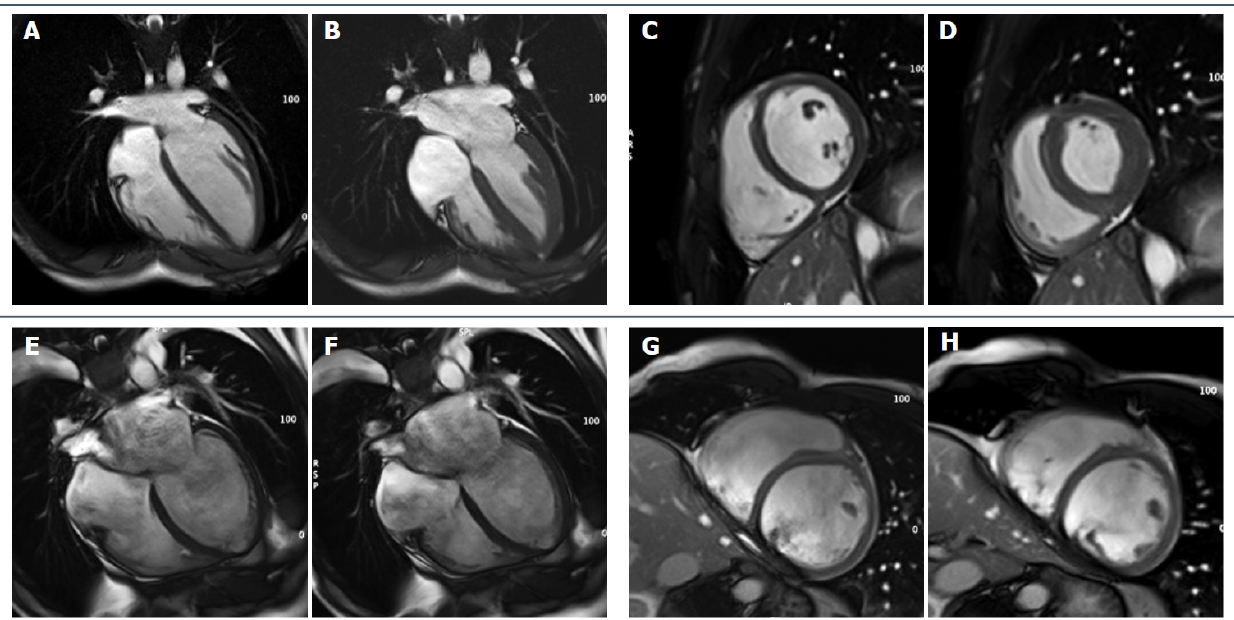
Figure 4. ( A – D ): 28-year-old male endurance athlete; SSFP cine sequences ( A , C ): diastolic frames